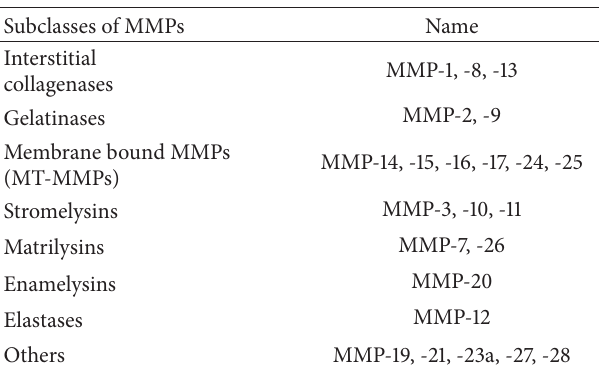
Table 1: Classification of matrix metalloproteinases (adapted from [28,